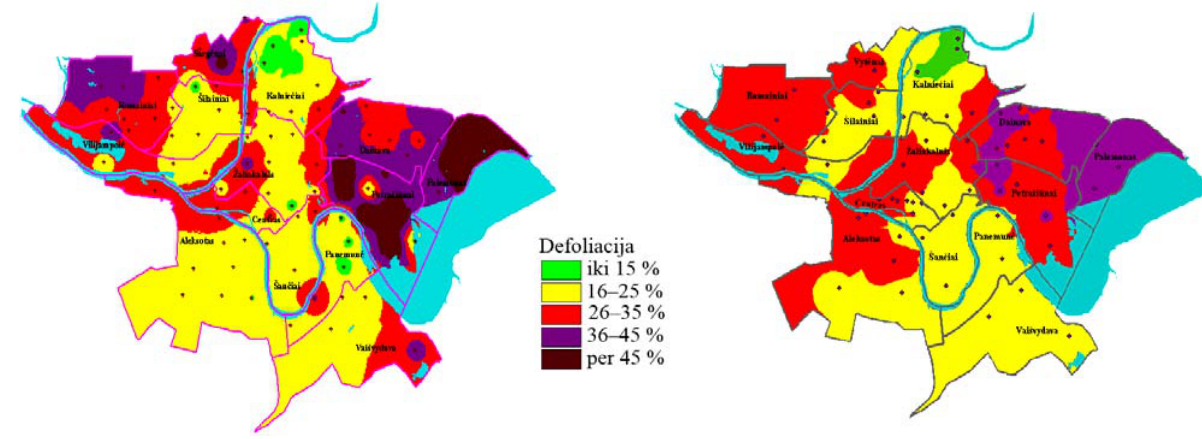
Fig. 9. Kaunas city zones according to average crown defoliation of sampled trees in 2002 (left) and in 2008